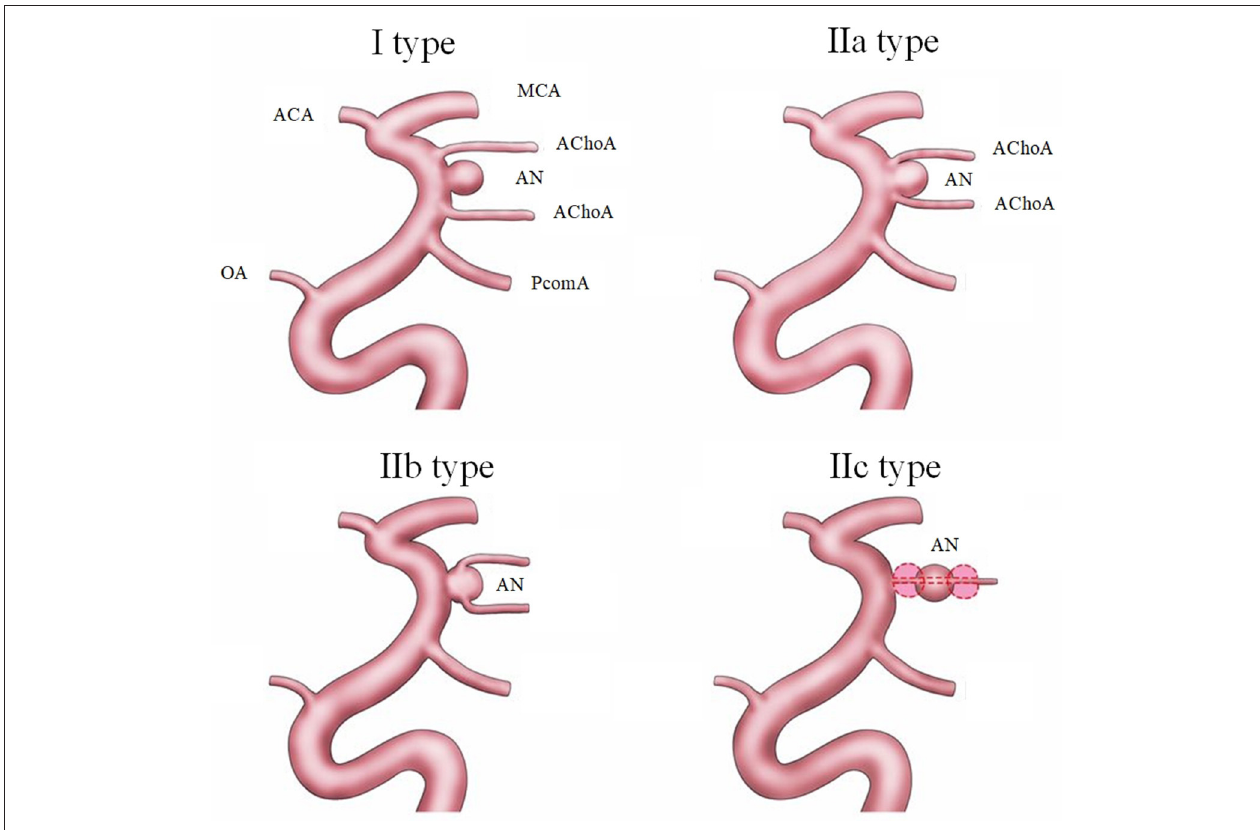
FIGURE 1 | The new classification of AChoA aneurysms includes I type (dependent type) and II type (independent type). The II type is further divided into three subtypes: IIa type, (neck), where the AChoA originates from the neck of the aneurysm; the IIb type (body), where the AChoA originates from the body of the aneurysm; and the IIc type (direct), where the aneurysm originates directly from the